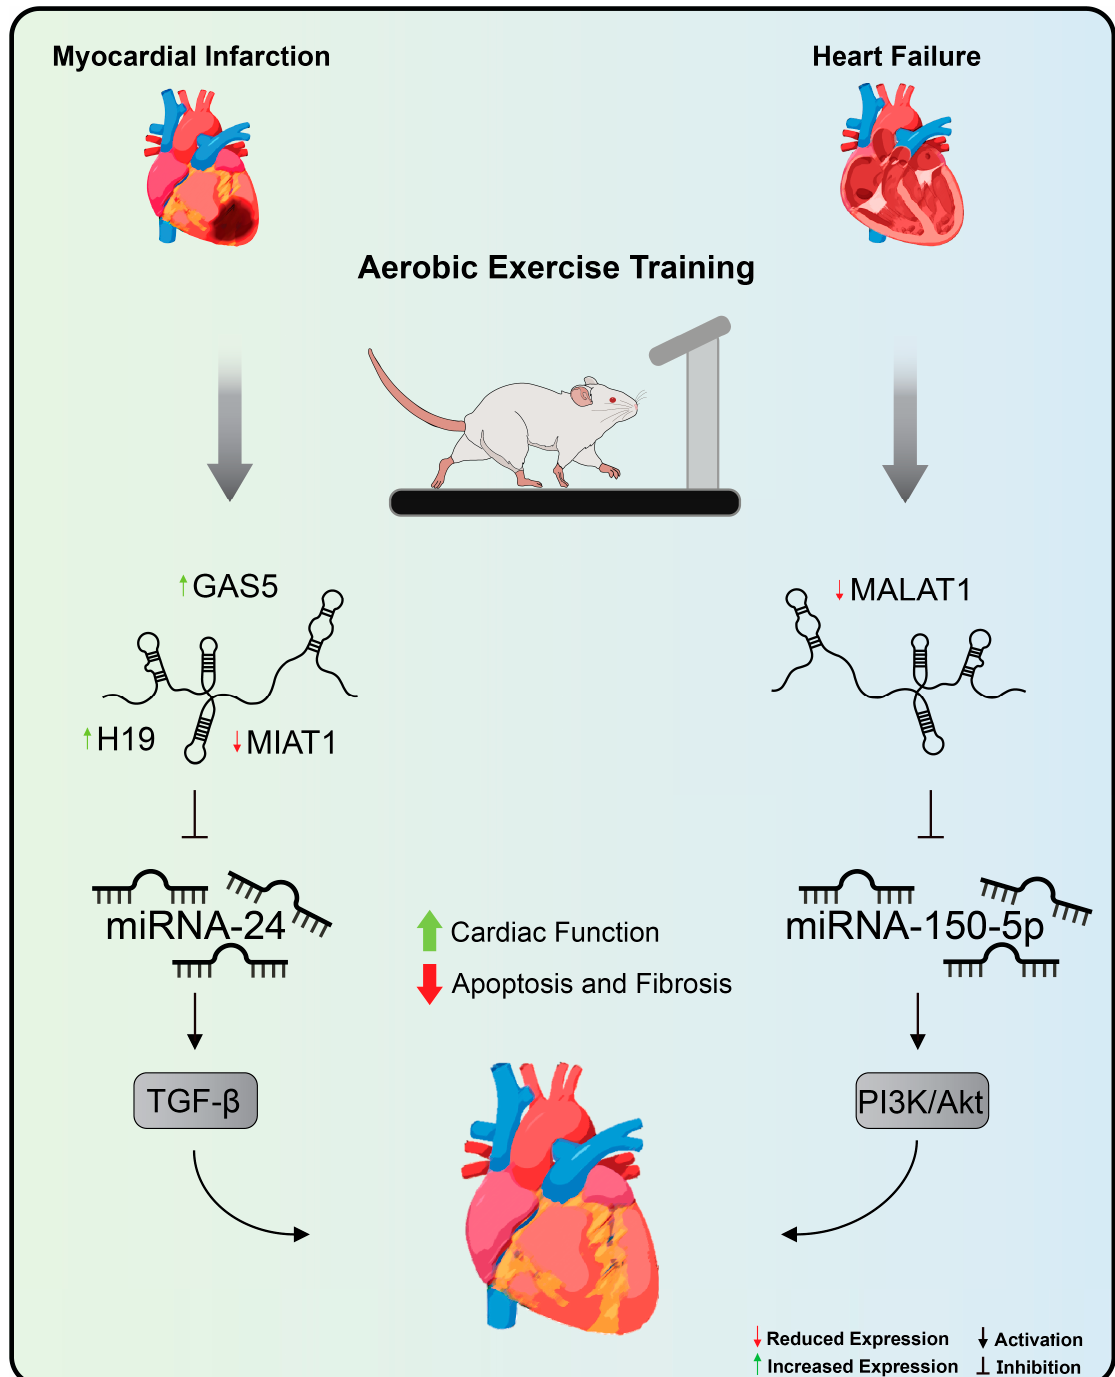
Figure 4. Aerobic exercise training’s effects on lncRNA expression in cardiovascular diseases. Treadmill exercise promoted, by decreasing MALAT1 and increasing miRNA-150 expression levels, improvements in cardiac function and left ventricular remodeling in rats with heart failure. In addition, aerobic exercise promoted a reduction in apoptosis of cardiomyocytes and fibrotic areas in the heart of rats after myocardial infarction through the normalization of levels of expression of H19, MIAT, and GAS5. Exercise training inhibits MIAT expression, a lncRNA with pro-fibrotic action in the myocardial infarction that acts by sequestering miRNA-24 and stimulating the TGF-beta pathway. MALAT1: metastasis-associated lung adenocarcinoma transcript 1, MIAT: myocardial infarction-association transcript, and GAS5: growth arrest specific